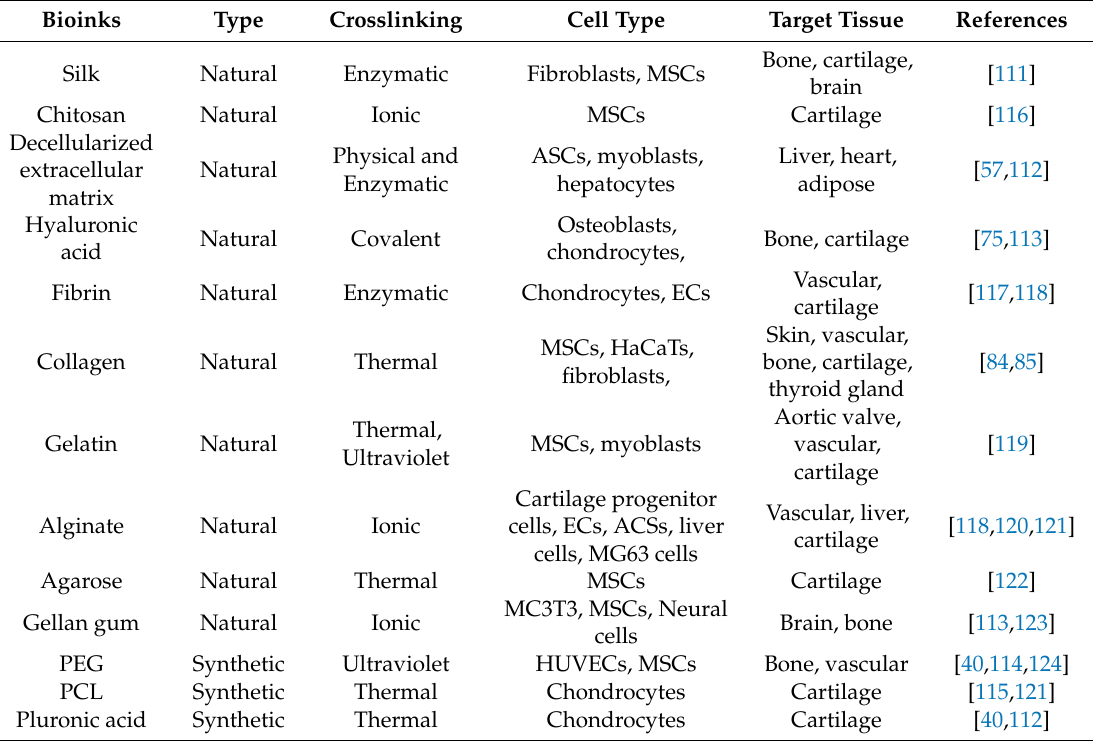
Table 2. Summary of various